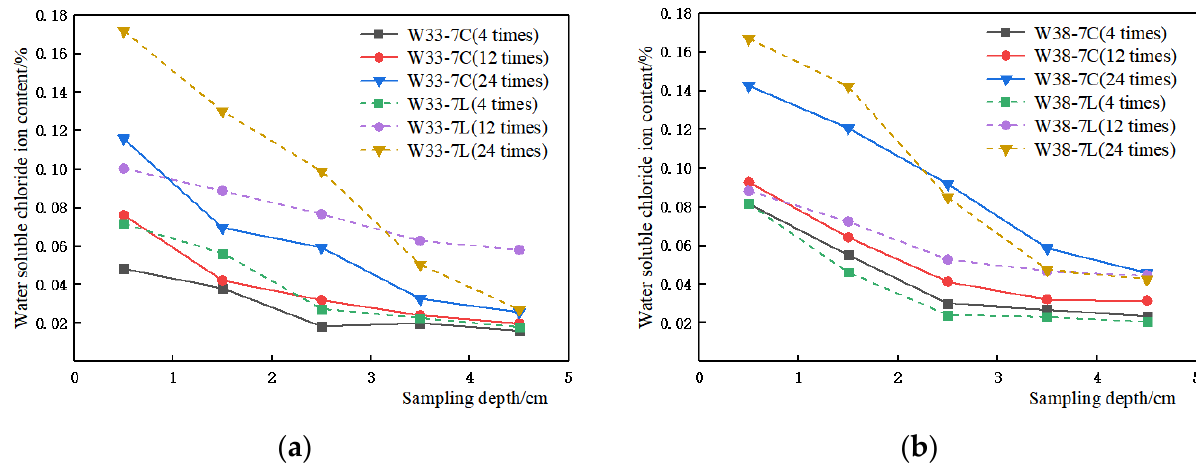
Figure 5. Comparison of ultimate bearing capacity in two models with different numbers of cycles: ( a ) W/C ratio of 0.33; ( b ) W/C ratio of 0.38.